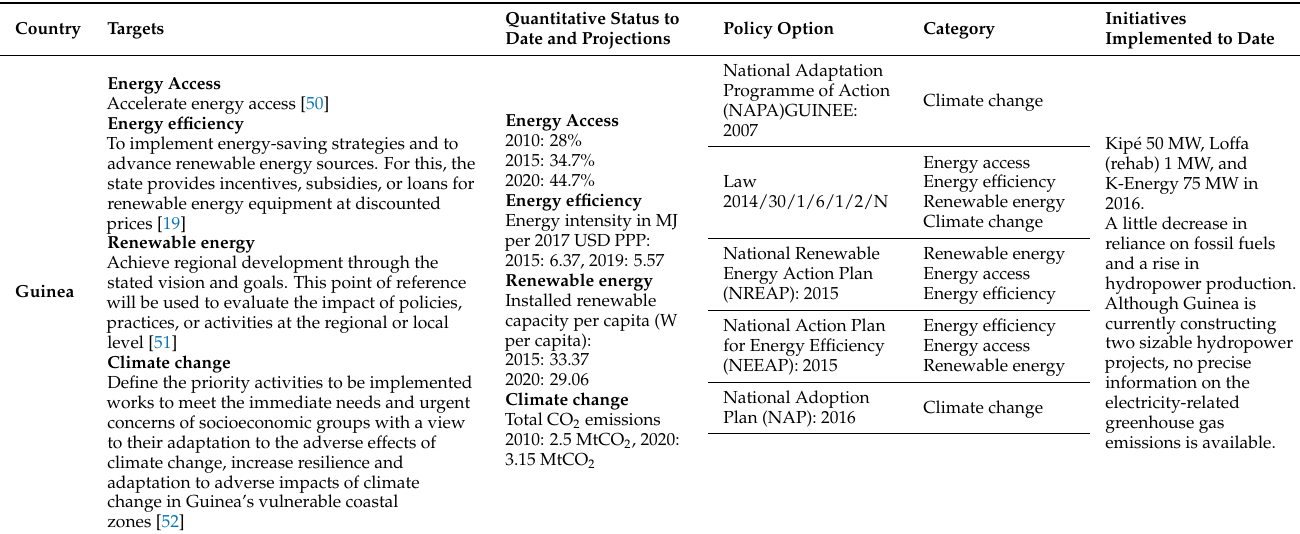
Table 7. Guinea (data from